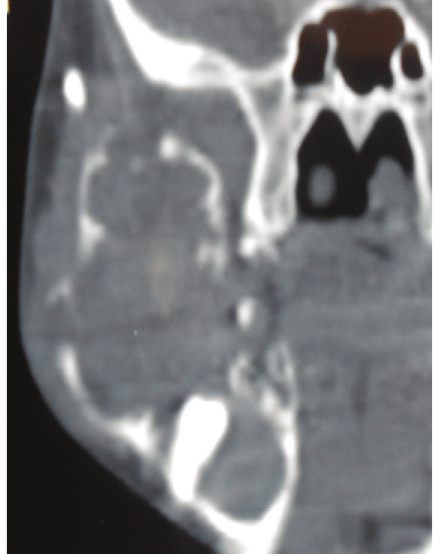
Figure 5: CT scan of the patient showing bicortical expansion with perforation.